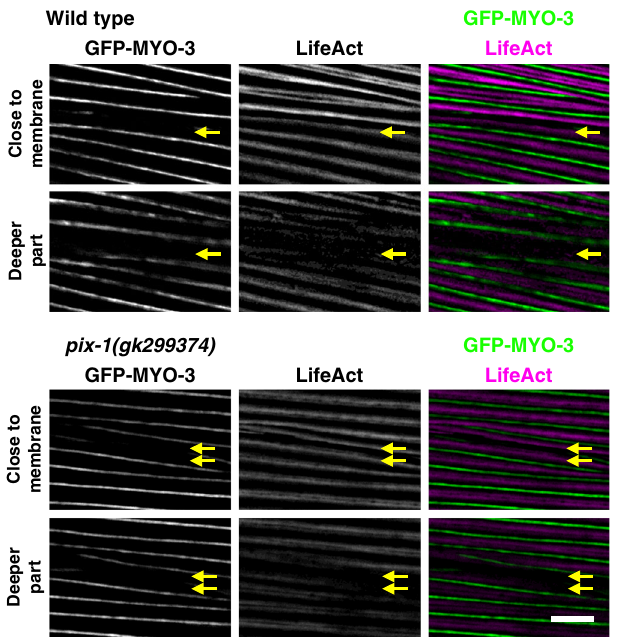
Fig. 2 Live imaging of cortical F-actin at muscle cell boundaries. SIM images of portions of two adjacent body wall muscle cells from a nematode strain in which a muscle myosin MHC A was tagged with GFP by CRISPR and LifeAct-mCherry was expressed in muscle cells from a transgene. GFP- MYO-3 (MHC A) labels the middle of sarcomeric A-bands, and LifeAct- mCherry labels I-bands, except for F-actin at the boundary between two adjacent muscle cells (indicated by yellow arrows). Note how the signal from the F-actin at the boundary diminishes as the focal plane changes from close to the outer muscle cell membrane to deeper into the myo fi lament lattice whereas the F-actin signal from I-bands does not change. Also note that in the pix-1 nonsense mutant, gk299374 , there are two bands of cortical F-actin at the boundary. Each image is a representative image obtained from imaging at three different animals of each strain. Scale bar, 5 μ PIX-1 acts as a GEF for the Rac, CED-10, in muscle . PIX